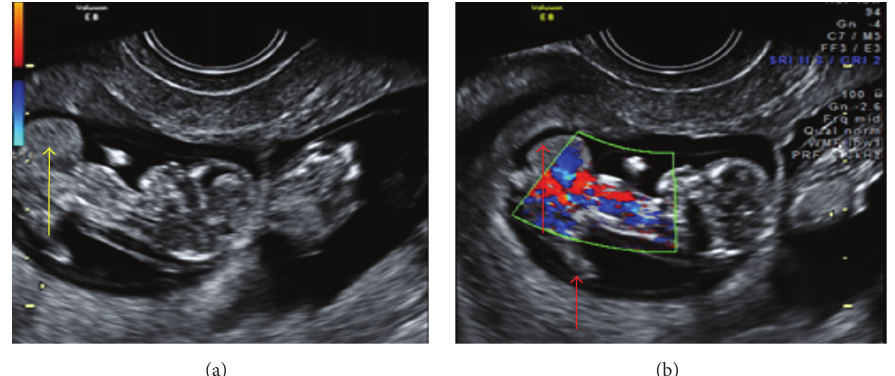
Figure 8: (a and b) Twins with LBWC in one fetus showing herniation of liver in extra embryonic coelomic cavity and abnormally placed lower limbs.